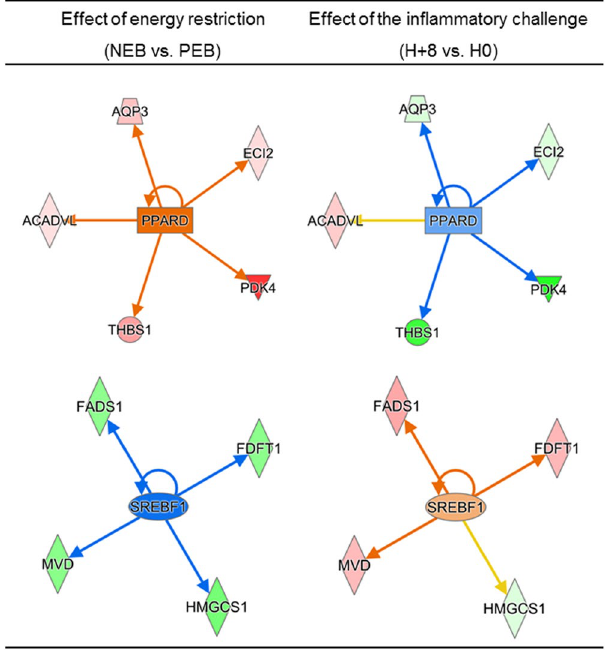
Figure 3. Predicted transcription regulators related to DEGs (q-value < 0.05) for both response to energy restriction and early response to the inflammatory challenge. Molecules highlighted in green were down- regulated and molecules highlighted in red were up-regulated.